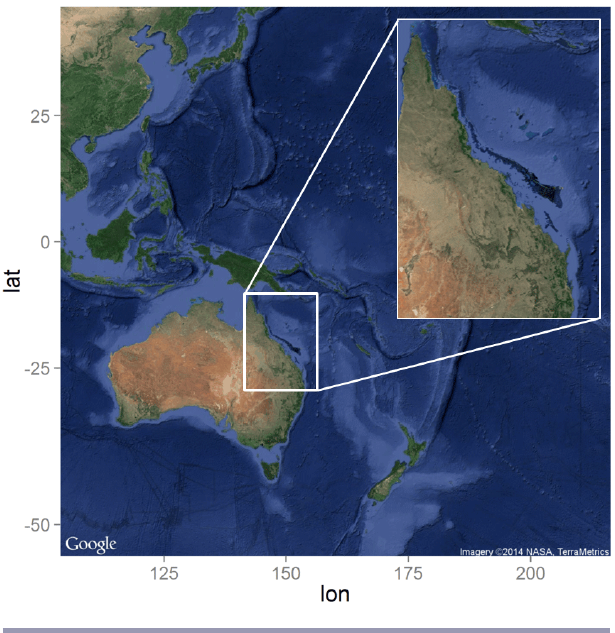
Fig. 1 . Map illustrating the coral reef fin-fish fishery (CRFFF) range on Australia’s east coast and the Great Barrier